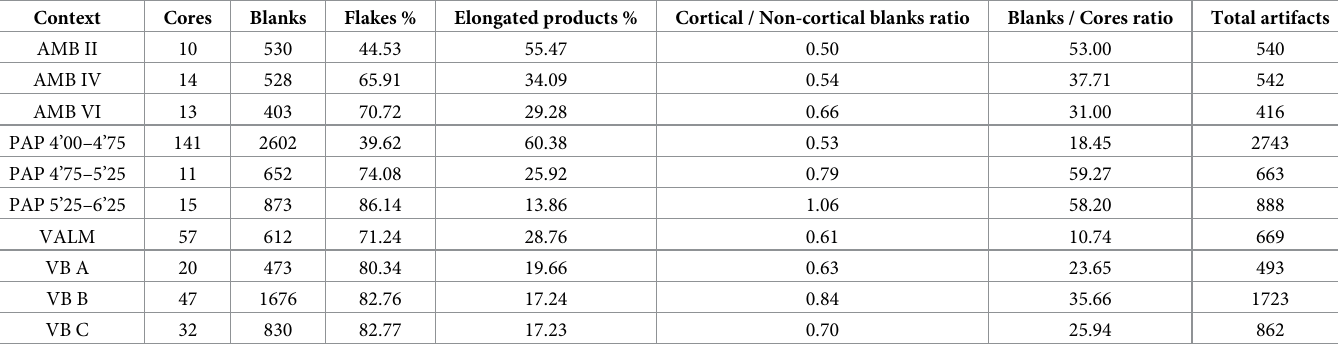
Table 3. General counts and ratios for each